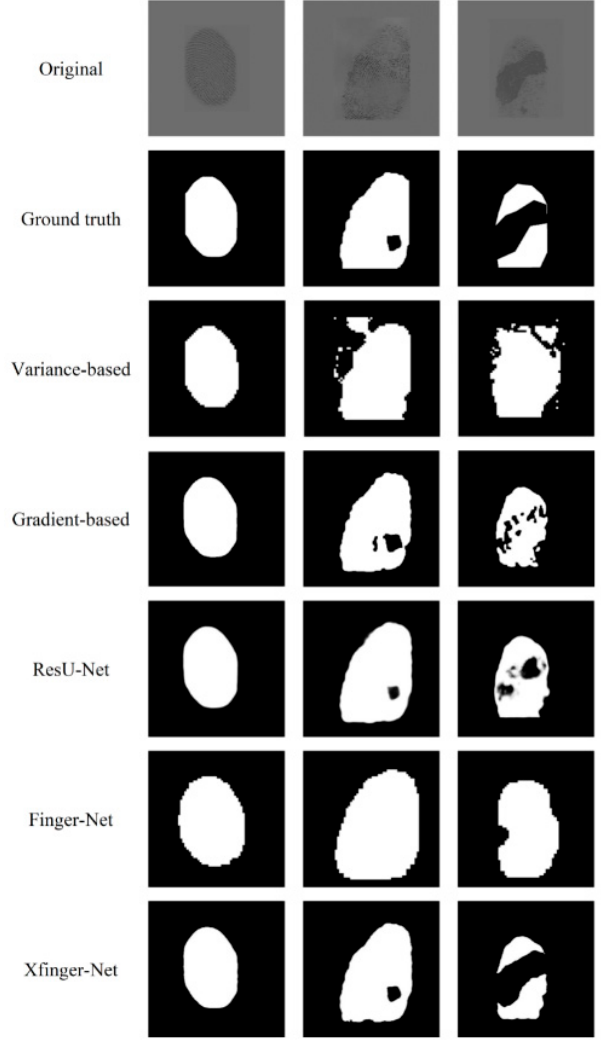
Figure 11. Comparison of the effects of XFinger-Net, ResU-Net, gradient-based methods.